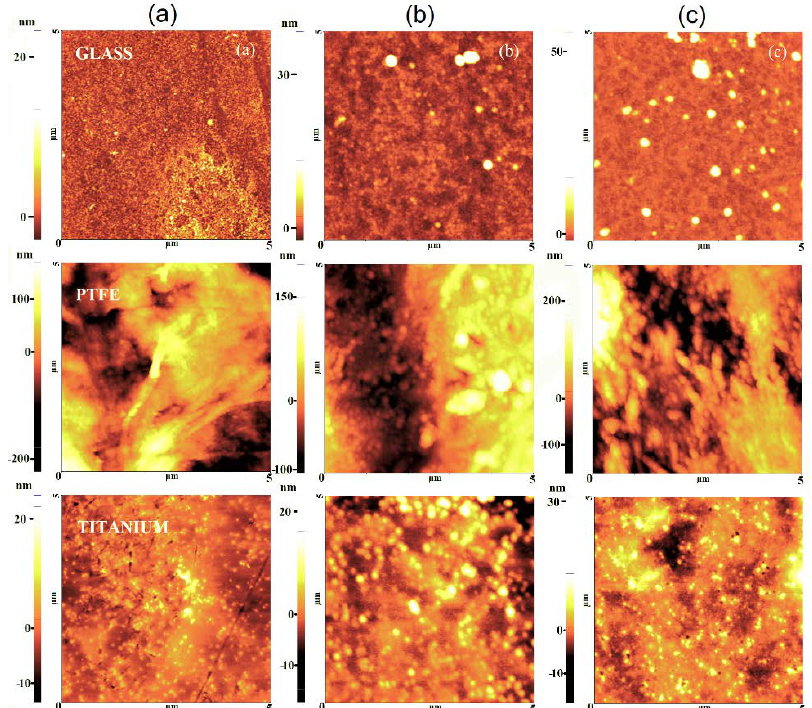
Figure 13. AFM images of thin films deposited on glass, PTFE and titanium in RF plasma: ( a ) Control, ( b ) Condition A, and ( c ) Condition B,